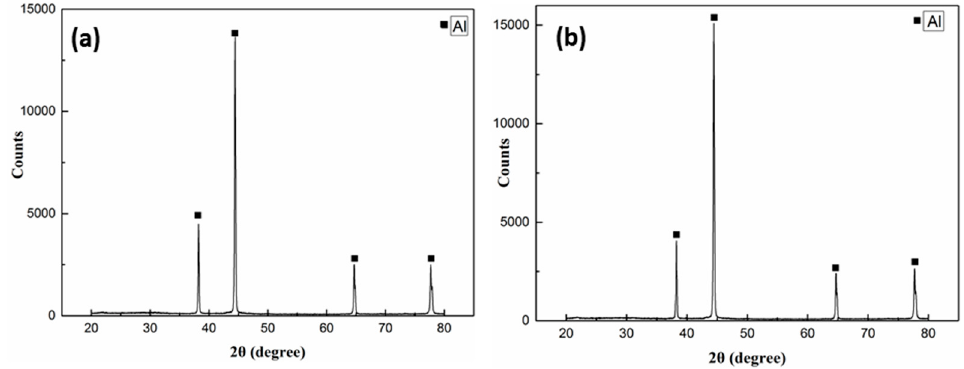
Figure 4. XRD result of the as-received plate ( a ) and diffusion bonding zone (520 °C–6 MPa–60 min) of 1420 Al–Li alloy assisted by pure Al interlayer ( b ).